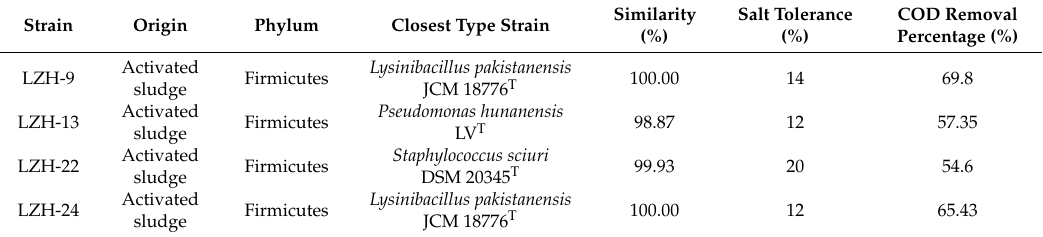
Table 1. Based on 16S rRNA and chemical oxygen demand (COD) removal e ffi ciency of four halotolerant